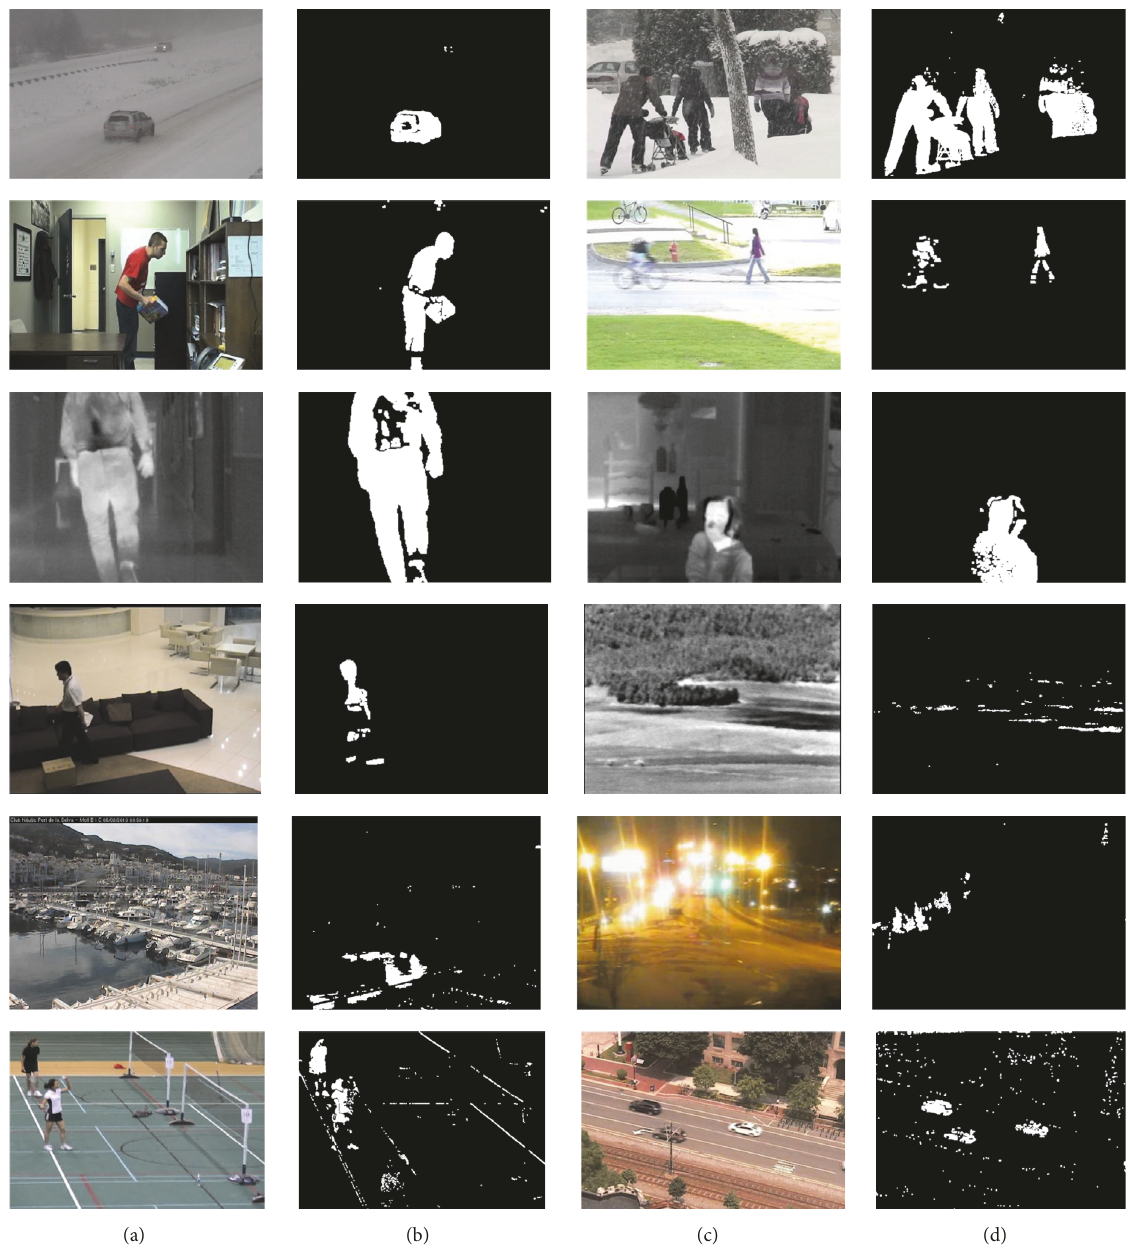
Figure 8: Detection results of other categories. (a) and (c): input test video; (b) and (d): detection results. The first row is the “Bad Weather” category, the second row is the “Baseline” category, the third row is the “Thermal” category, the fourth row is “Intermittent Object Motion” category and “Turbulence” category, the fifth row is “Low Framerate” category and “Night Videos” category, and the sixth row is “Camera Jitter” category and “PTZ”